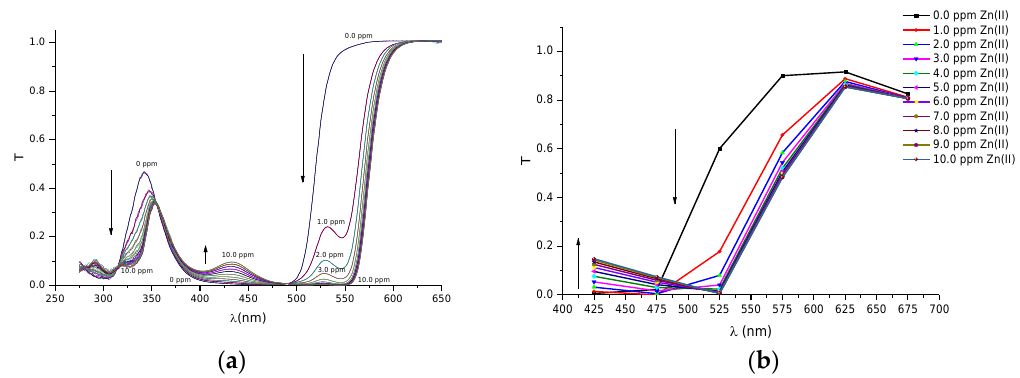
Figure A3. The transmittance spectra of the chromogen reagent of 1-(2-pyridylazo)-2-naphthol (PAN) solution containing Zn(II) ions at different concentrations corresponding to: ( a ) The UV-VIS Cary ® 50-Varian spectrometer ( b ) the multiespectral MMCS6CS sensor.